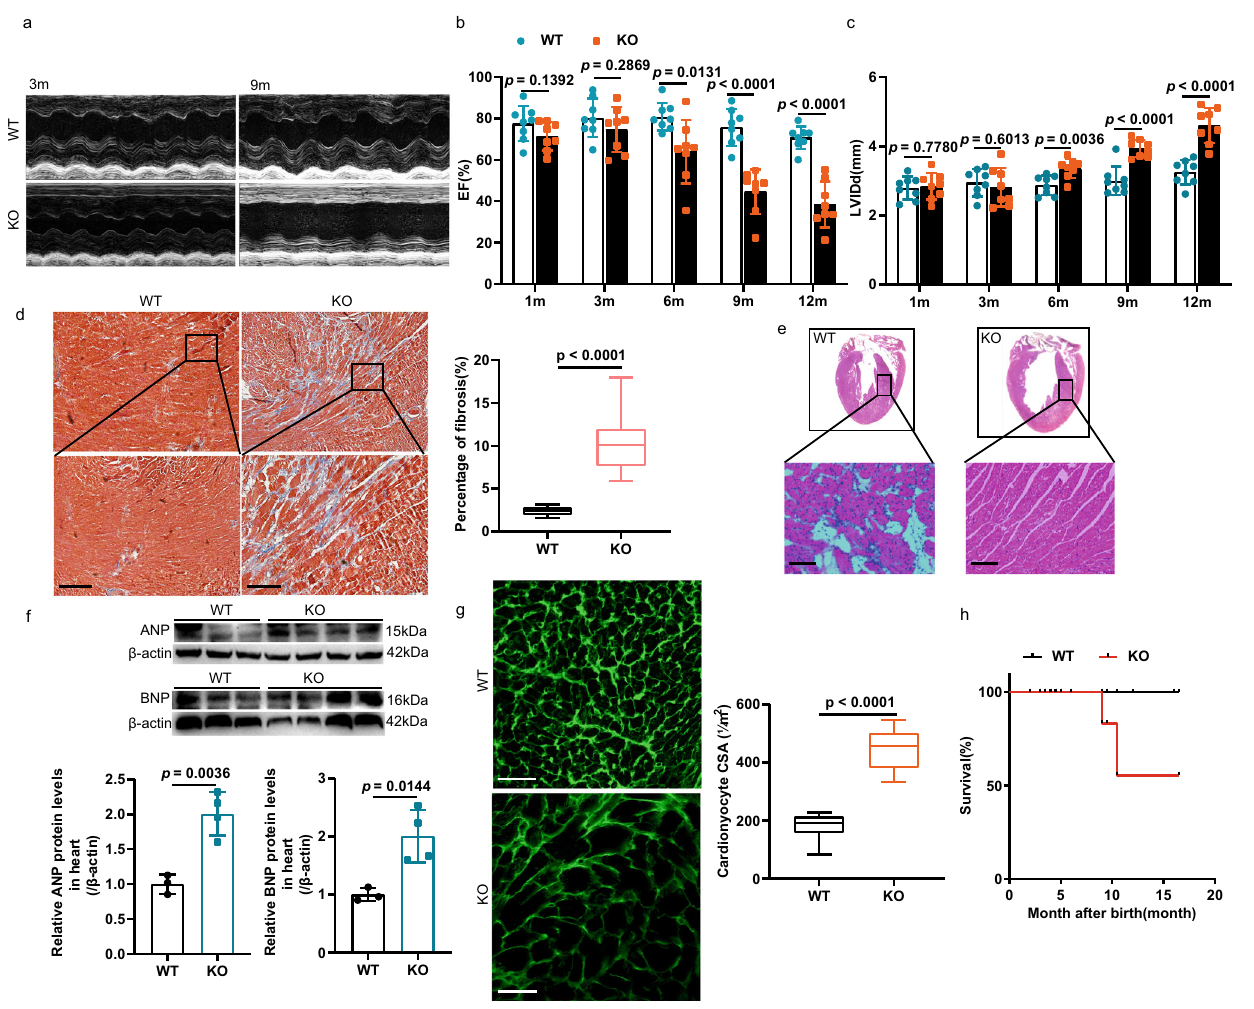
Fig.4|KOmicedisplayedcardiachypertrophyandHF. KOmiceandWTmiceof different ages were compared. a Representative examples of longitudinal M-mode echocardiography in 3-month-old and 9-month-old KO and WT mouse hearts are shown. b Decreased ejection fraction (EF) ( n =8 mice/group). c Increased end- diastolic left ventricle inner diameter ( n =8 mice/group). d Masson ’ s trichrome staining analysis of myocardial tissue with severe fi brosis ( n =3 mice/group, 8 sec- tions/mouse); scale bar: 500 μ m. e Analyses of gross heart morphology and H&E- stainedlongitudinalsectionsofmyocardialtissueshowingadisorderedmyocardial arrangement (n=3 mice/group, 8 sections/mouse); scale bar: 100 μ m. f Western blot analysis showing the increased expression of cardiac hypertrophy markers in cardiac tissue (WT, n =3 biologically independent samples; KO, n =4 biologically